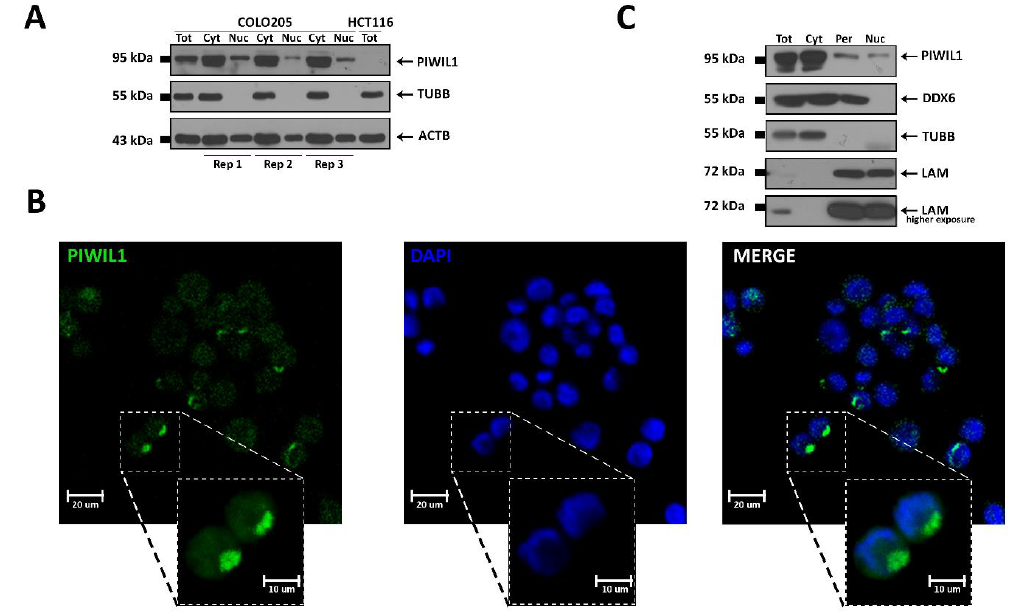
Figure 3. Characterization of PIWIL1 subcellular distribution. ( A ) Cell fractionation performed in triplicate in COLO 205 cells revealed the presence of PIWIL1 in both cytoplasmic and nuclear compartments; as a comparison, total protein lysate from COLO 205 and from HCT 116 (negative control) were run on the same gel; β -actin (ACTB) was used as a loading control, while β -tubulin (TUBB) was used to verify the absence of cross-contamination between cytosolic and nuclear fractions. ( B ) Localization of PIWIL1 protein (green) in COLO 205 cells by immunocytochemical analysis revealed its presence in both compartments, nucleus and cytosol, with especially bright staining in a discrete region located in proximity of the nucleus (blue, DAPI staining). ( C ) Cytosol/perinucleus/nucleus fractionation showed the presence of PIWIL1 in the perinuclear region of COLO 205 cells; in the same fraction, DDX6 protein, a marker for the human germline nuage compartment, was detected; TUBB was used to verify the absence of cytoplasmic contamination of perinuclear and nuclear fractions and β -lamin (LAM) as a control for perinuclear and nuclear extraction. As a comparison, total protein lysate from COLO 205 was loaded on the same gel. In germline, PIWIL proteins and their interactors localize in proximity of the nucleus in a structure called nuage, where piRNA precursor transcripts are exported from the nucleus and biogenesis is thought to occur. To test the possibility that these somatic cells might contain a similar structure, we used a more stringent cell fractionation protocol [25] to isolate the perinuclear region of COLO 205, which was found to contain approximately 20% of the total protein content (Figure S9), and confirmed that ~10% cellular PIWIL1 is localized in the perinuclear region, ~4% in the nucleus,